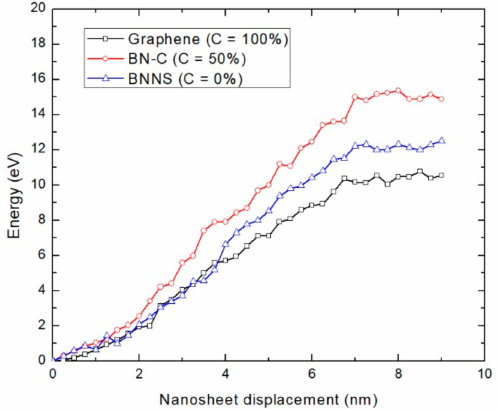
Figure 12. Plot of the variation of energy during the pull-out process of BN–C nanosheets with varying carbon atoms from the PE matrix at 300